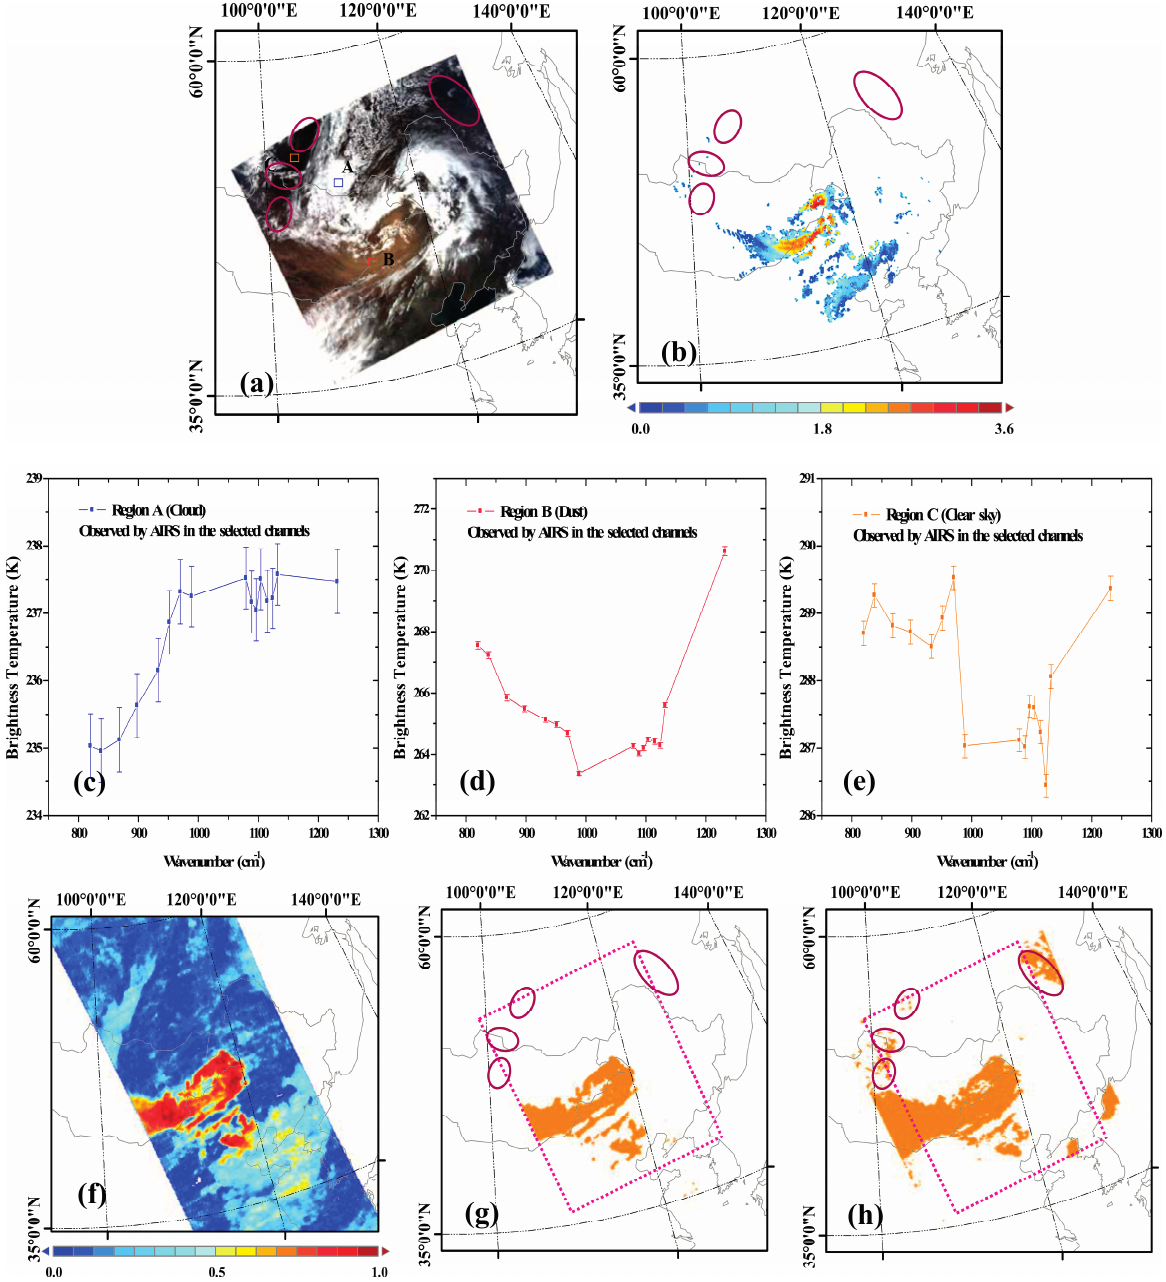
Figure 11. 11 May, 2011 ( a ) MODIS RGB composite image. ( b ) MODIS deep blue aerosol optical depth. ( c ) AIRS observations in cloudy region. ( d ) AIRS observations in dusty region. ( e ) AIRS observations in clear sky region. ( f ) DSSI . ( g ) Dust detection results based on DSSI. ( h ) Dust detection results based on “IR split windows”